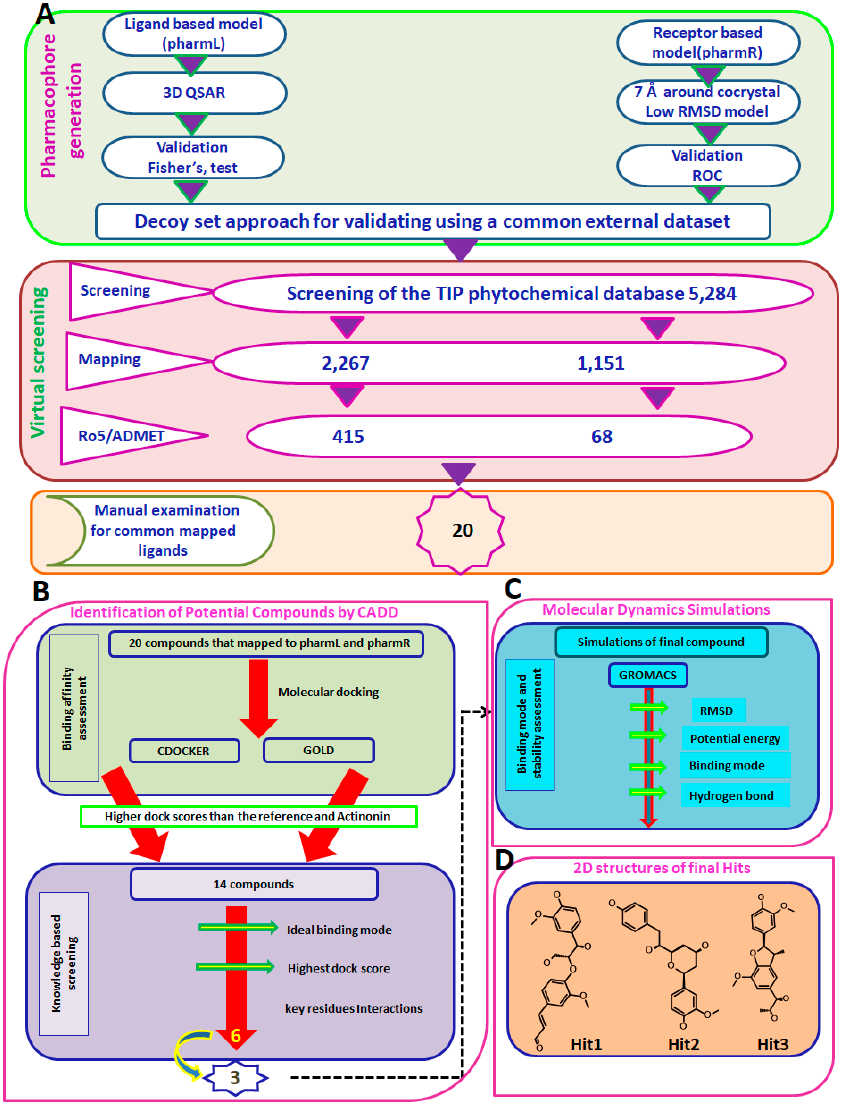
Figure 5. Computational methods to retrieve the potential candidate compounds. ( A ) Pictorial depiction of the generation of pharmacophore models and virtual screening process. ( B ) Sequential steps involved in binding affinities and knowledge based screening for potential compounds. ( C ) Evaluation of the binding modes and the stability of the final complex compounds through molecular simulations. ( D ) Two-dimensional representation of the potential compounds.